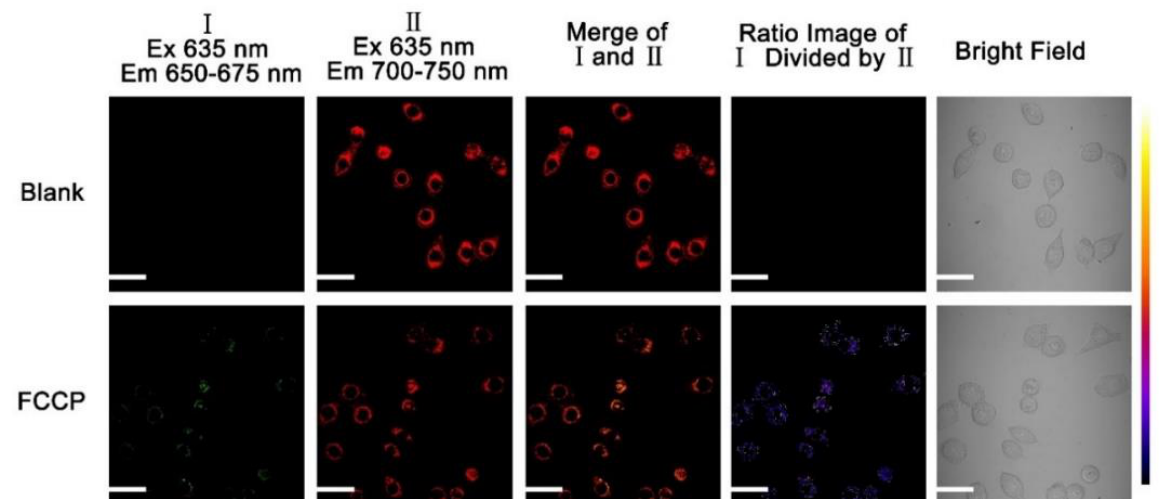
Figure 15. Fluorescence images of HeLa cells incubated with 10 µM probes BH + before and after FCCP treatment. The first and second channels in the fluorescence images were recorded from 650 nm to 675 nm, and from 700 nm to 750 nm under excitation at 635 nm, respectively. Scale bars: 10 µm. HeLa cells were incubated with 10 μM probe BH + for 20 min, and further treated with 10 μM FCCP in PBS at 37 °C for 20 min. Live cell images were obtained by an Olympus IX 81 confocal microscope. ImageJ software was used to obtain ratiometric images. The software is free from https://imagej.nih.gov/ij/, 2 April 2021.